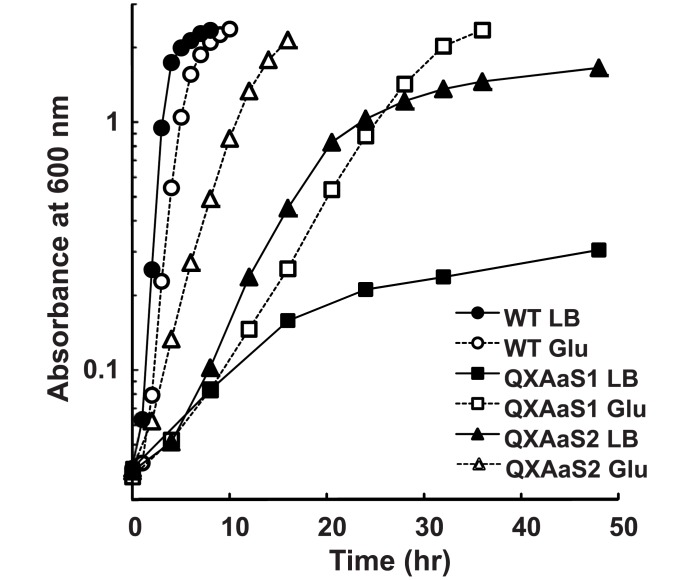
Growth profiles of the suppressor mutants.Strains were cultivated aerobically in 40 ml LB medium or glutamate medium in 100-ml Erlenmeyer flasks with shaking at 300 rpm. The results shown are representative based on three independent experiments. The maximum specific growth rates (μmax) of WT, QXAaS1, and QXAaS2 were 1.30 ± 0.089, 0.09 ± 0.008, and 0.26 ± 0.041 h−1, respectively, for LB medium and 1.06 ± 0.019, 0.15 ± 0.016, and 0.40 ± 0.034 h−1, respectively, for glutamate medium.